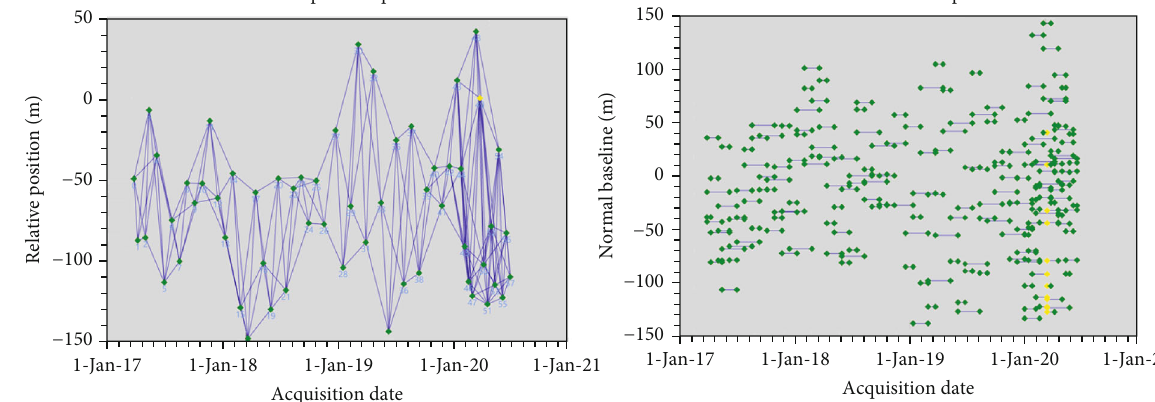
Figure 5: Spatial baseline (a) and temporal baseline